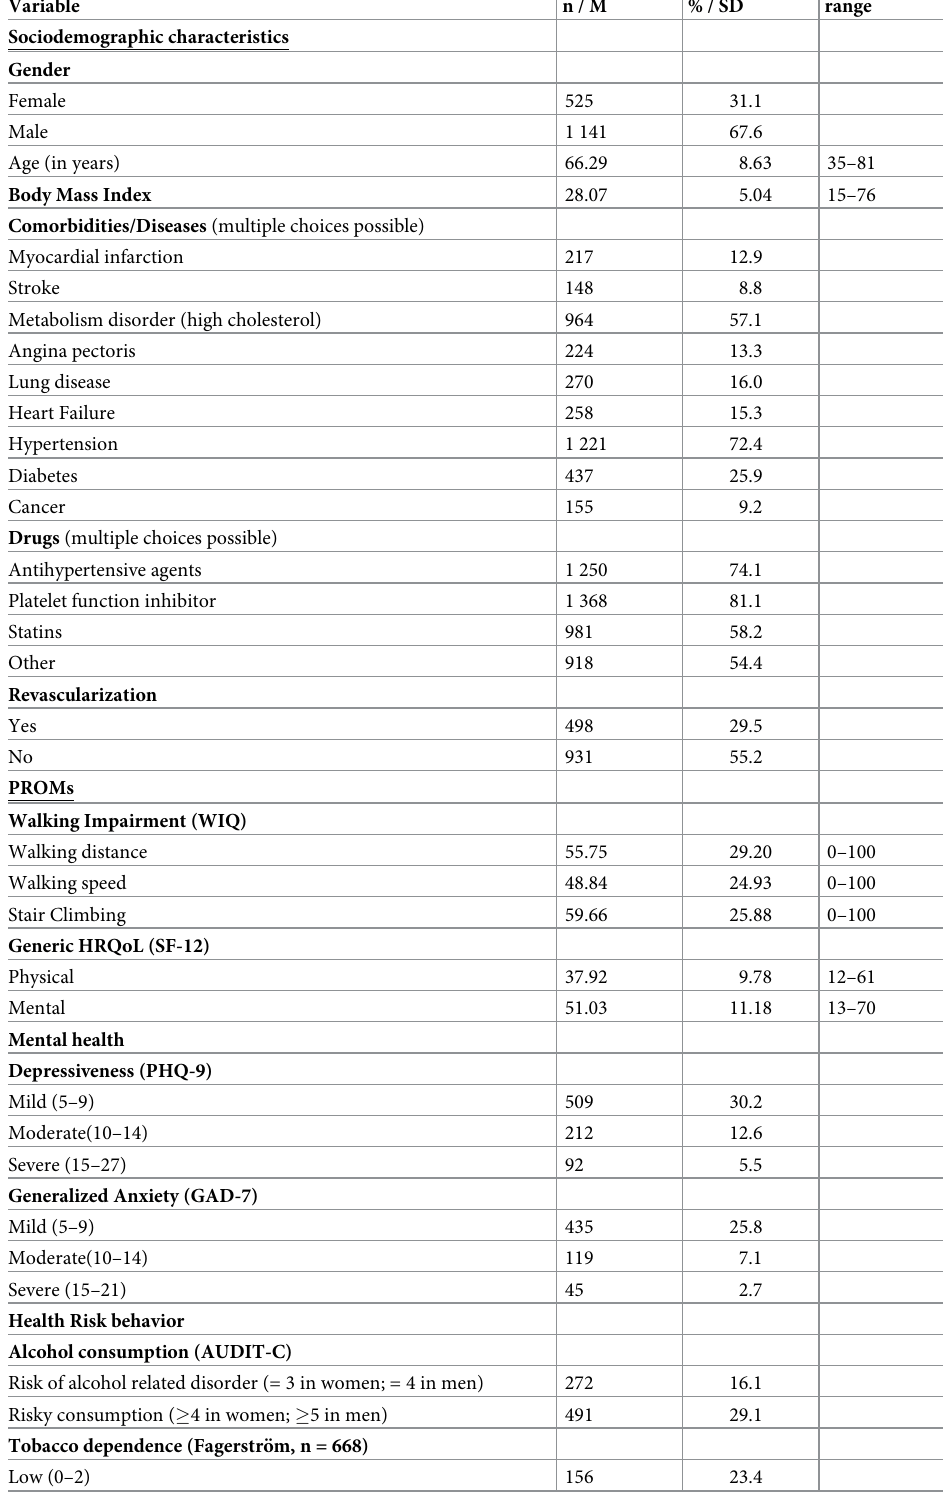
Table 1. Characteristics of the study